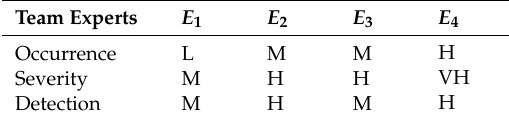
Table 4. Linguistic evaluations of risk factor weights.